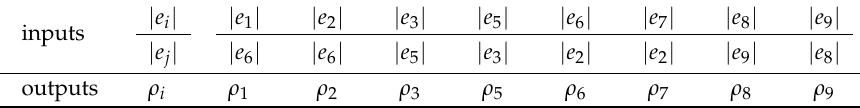
Table 2. Relationships between two input variables and an output